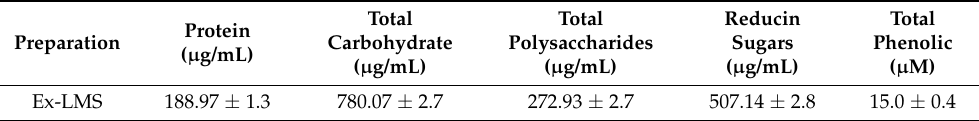
Table 2. Number of proteins, total polysaccharides, reducing sugar, and total phenolic compound content of tested ex-LMS preparation